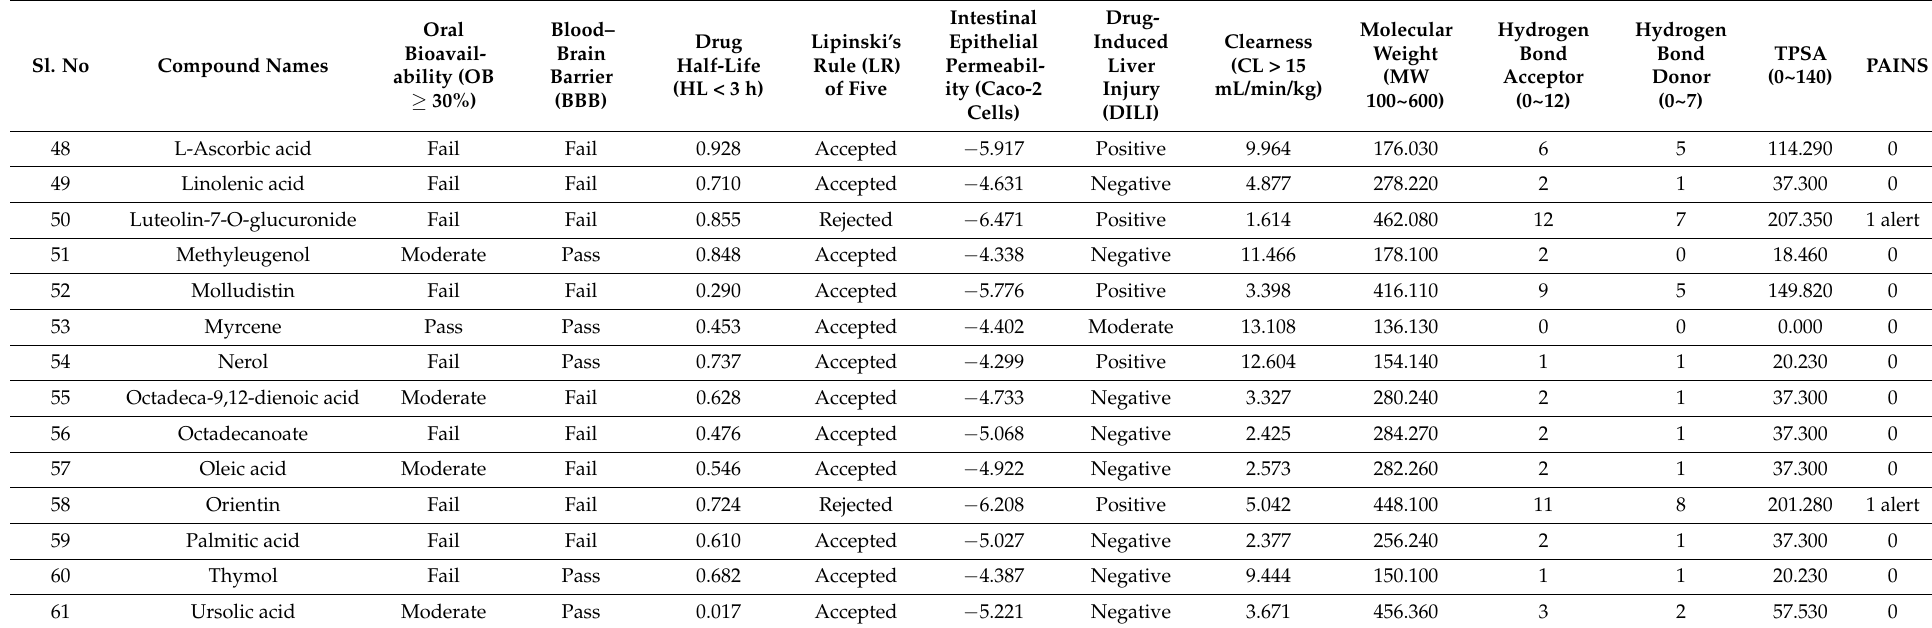
Table 3. Screening of active compounds using ADMET